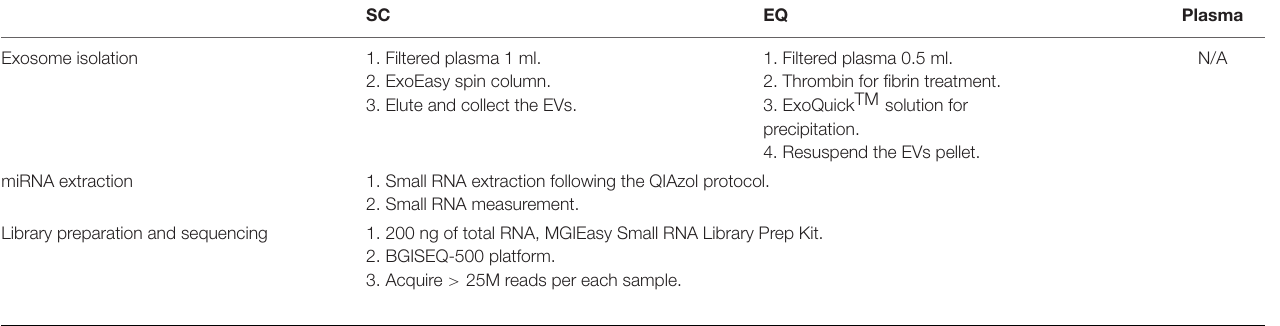
TABLE 2 | Exosome isolation workflow.